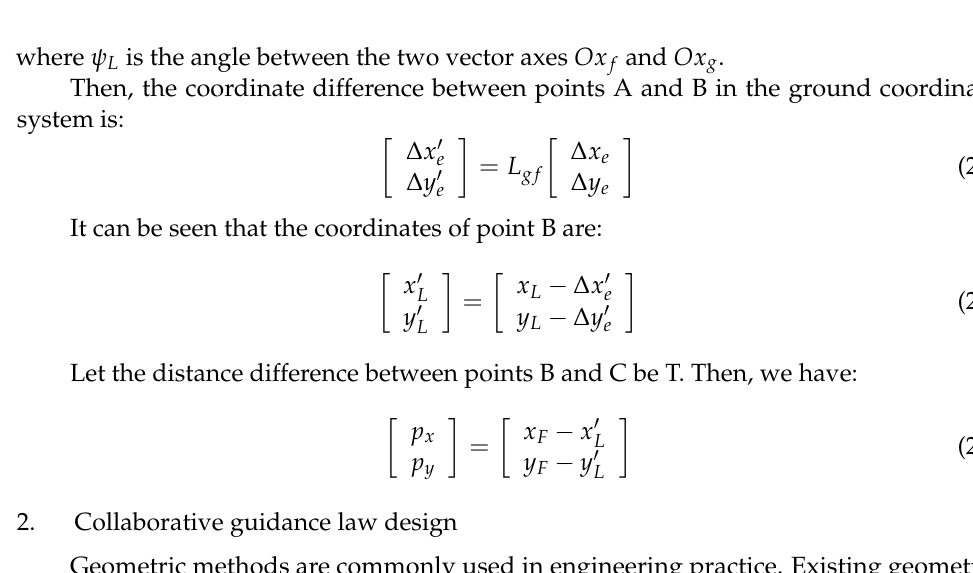
Table 1. Comparison of different guidance methods. Guidance Law Overload Trajectory Mobility Line-of-sight tracking Large Curved Poor Proportional guidance Small Slightly curved Strong Parallel approach Small Straight